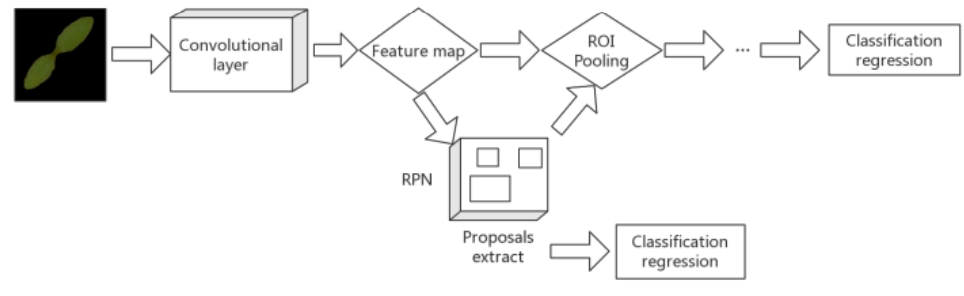
Figure 3. The Faster R-CNN network structure.